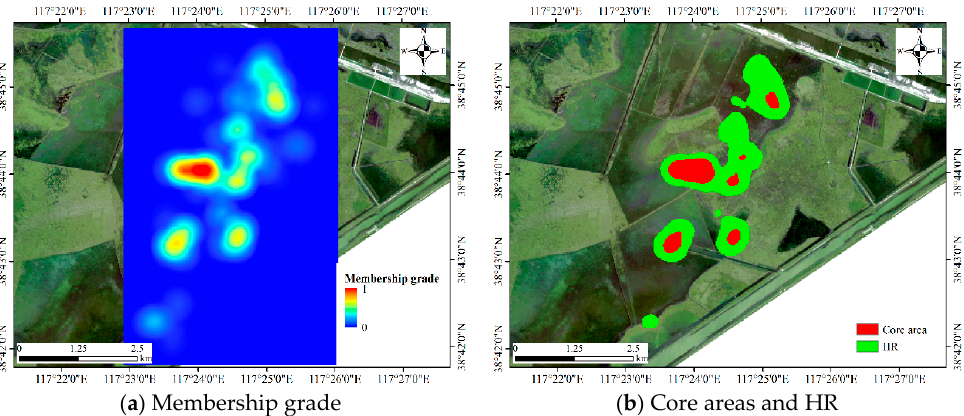
Figure 10. The membership grade, core areas and home ranges (HRs) of Dataset 1.